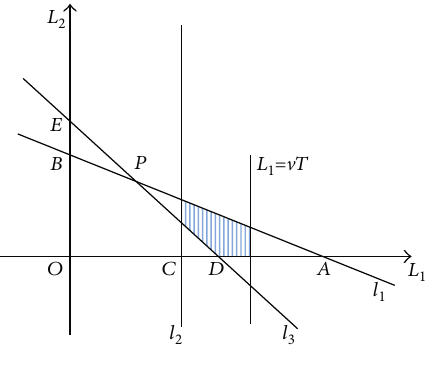
Figure 2: Coordinate